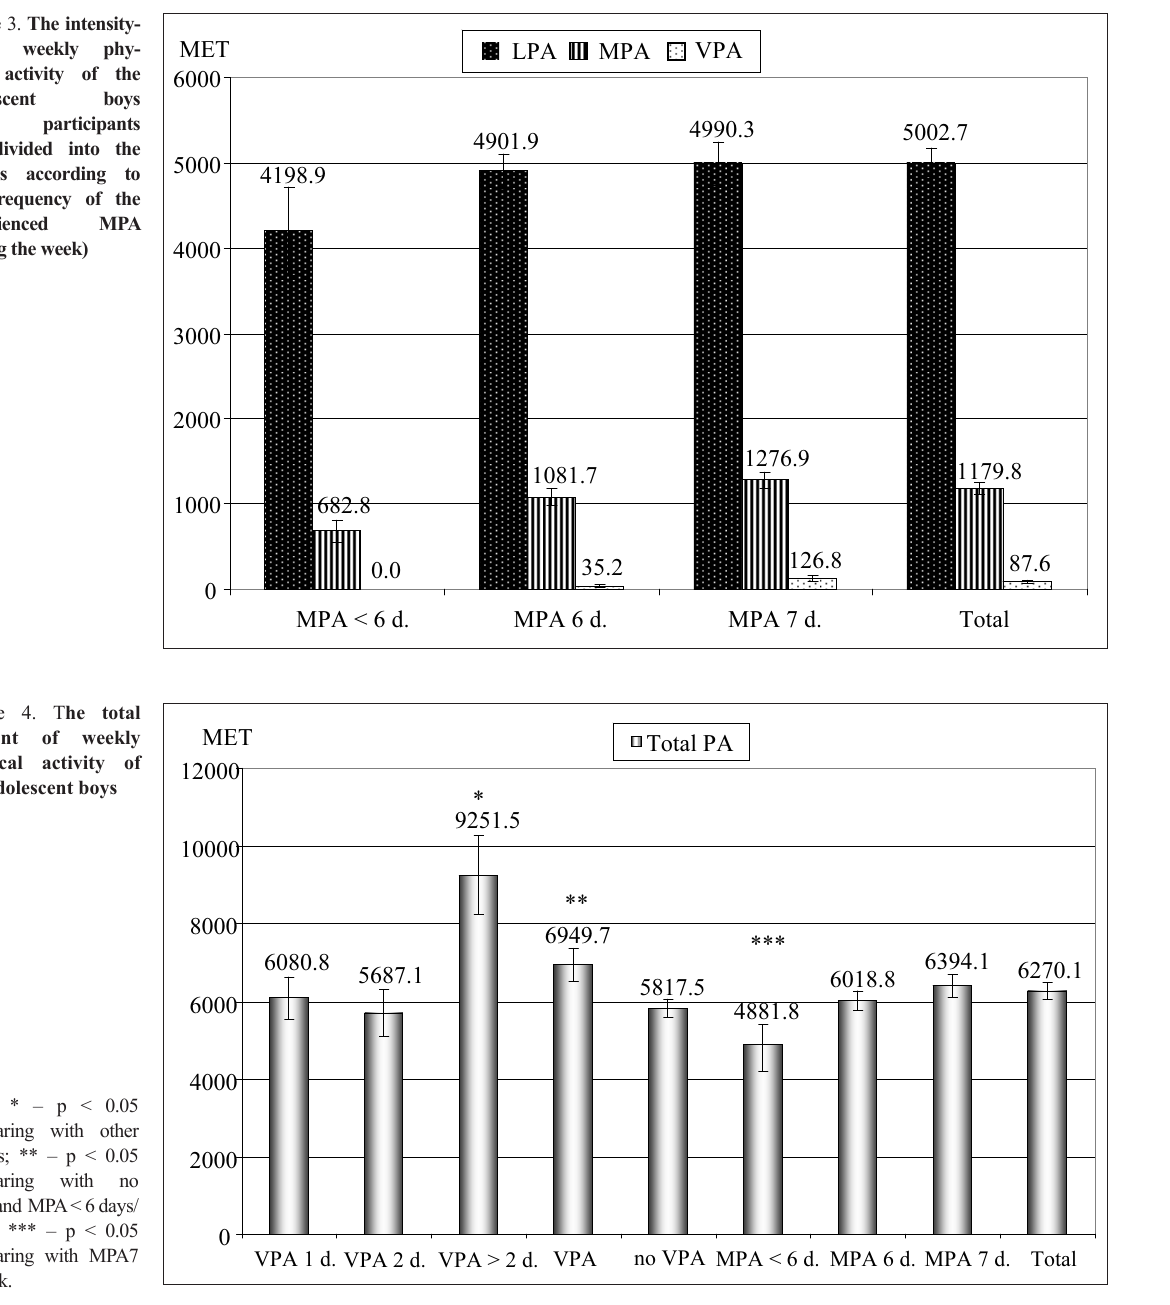
Figure 3. The intensity- based weekly phy-